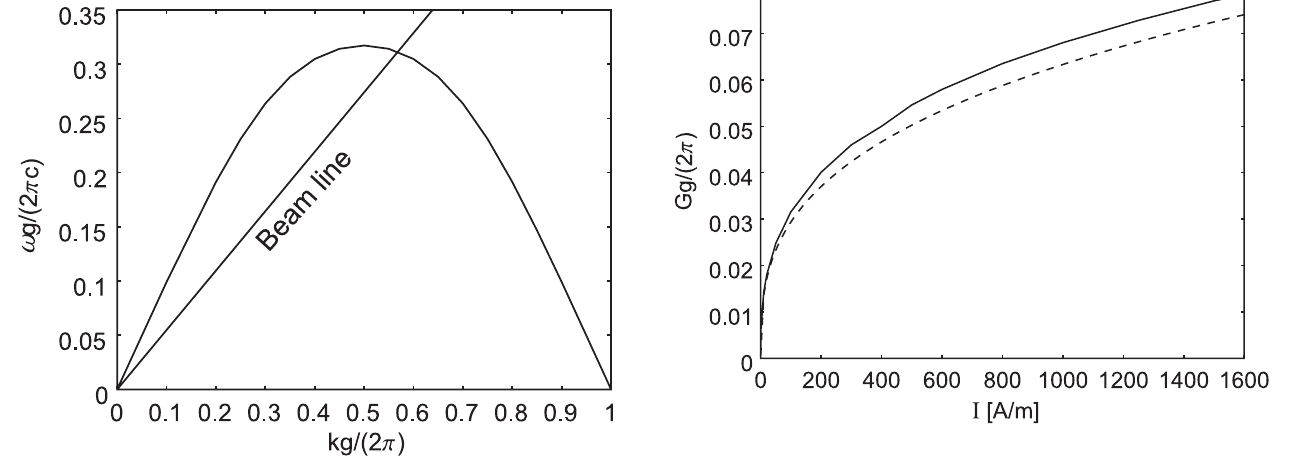
FIG. 3. Normalized small signal gain versus the beam current per meter in the y direction. The solid line corresponds to numerical solution of the dispersion relation Eq. (45), while the dashed line corresponds to approximate solution Eq.